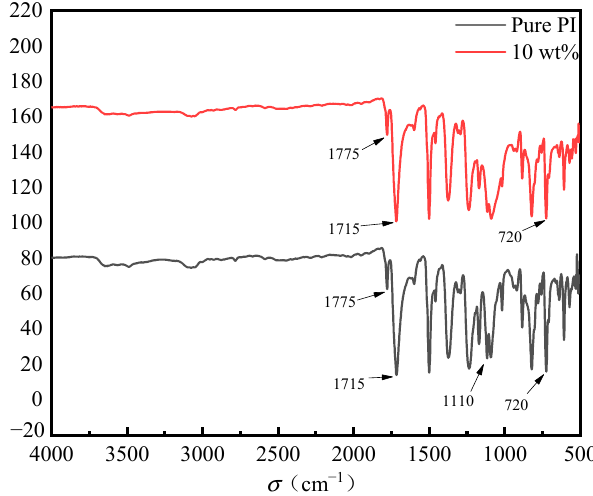
Figure 5. Infrared spectra of pure PI film and PI/nano-SiO 2 three-layer composite film with doping amount of 10 wt%.